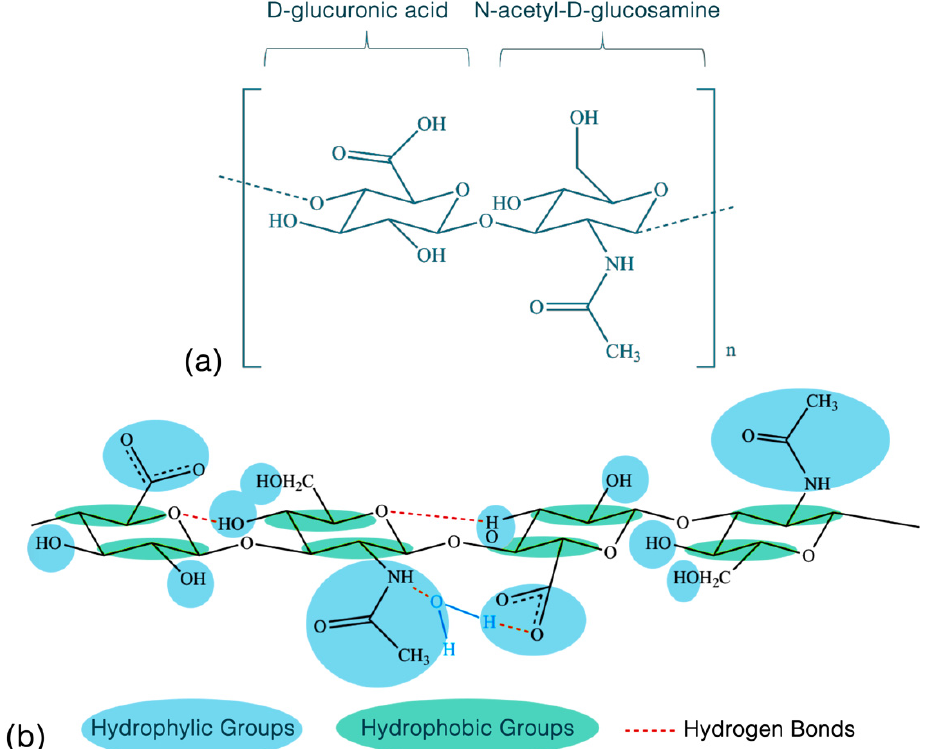
Figure 4. Chemical structure of the disaccharide unit of hyaluronan (HA). ( a ) Each HA molecule consists of variable-length chains made up of repeating disaccharide units, each composed of D- glucuronic acid and N-acetyl-D-glucosamine. ( b ) Each hyaluronan molecule features a large number of hydrophilic groups and intra-molecular hydrogen bonds, responsible for its high water-binding affinity and viscoelastic properties. Reproduced from Fallacara et al. [48], with